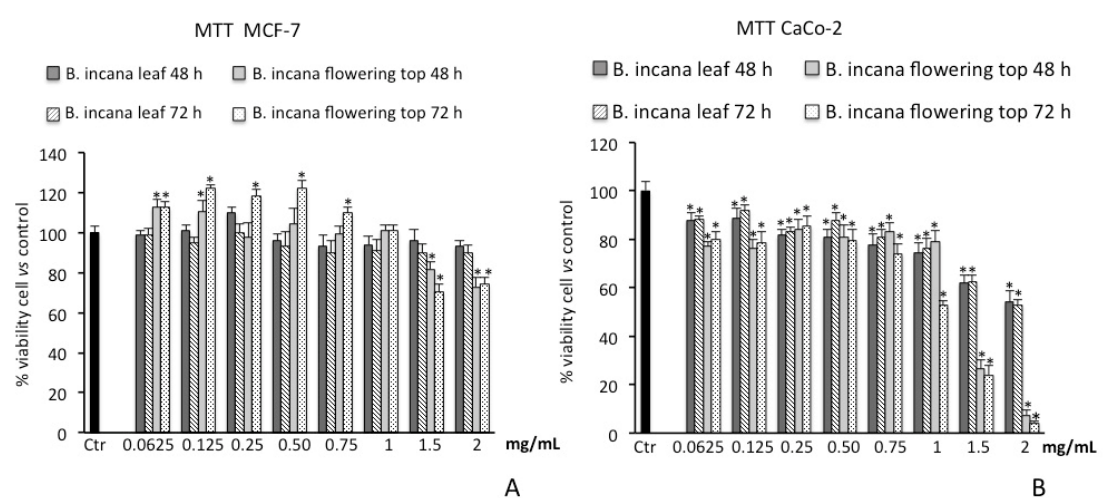
Figure 4. Cell viability in MCF-7 ( A ) and CaCo-2 ( B ) cells untreated and treated for 48 h and 72 h with B. incana leaf and flowering top hydroalcoholic extracts. Values are the mean ± SD of four experiments in triplicate. * Significant vs. untreated control cells: p < 0.001. MTT, 3-(4,5-dimethylthiazol-2-yl)-2,5-diphenyltetrazolium bromide.